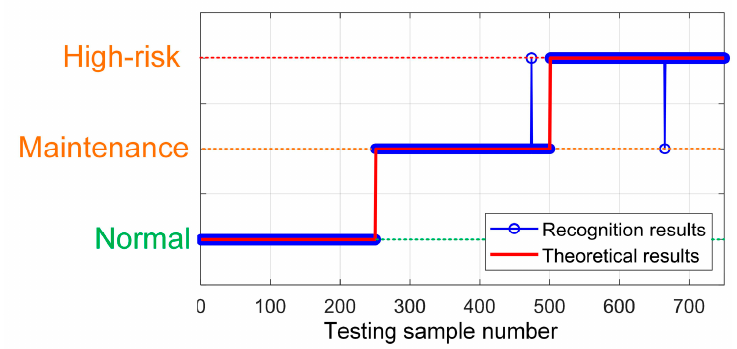
Figure 16. LGPG: maintenance pattern recognition results.